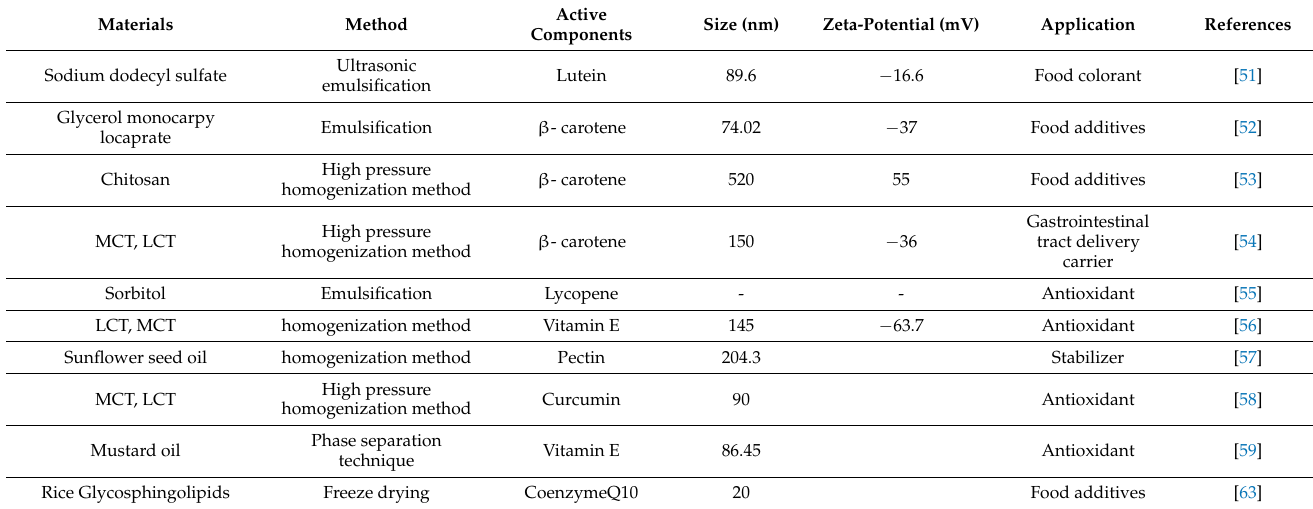
Table 2. Examples of nano-emulsions for functional food nanoparticle delivery